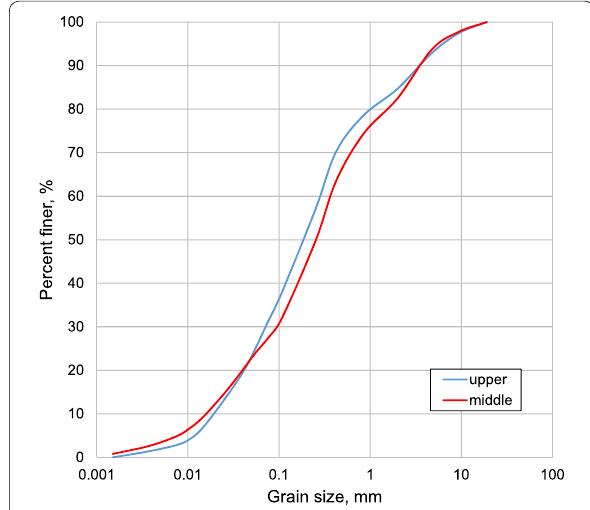
Fig. 8 Grain size distribution of Ta-d soil samples. Upper: sample collected from the upper part of the layer; Middle: sample collected from the middle part of the layer. Both the sampling locations were marked in Fig.